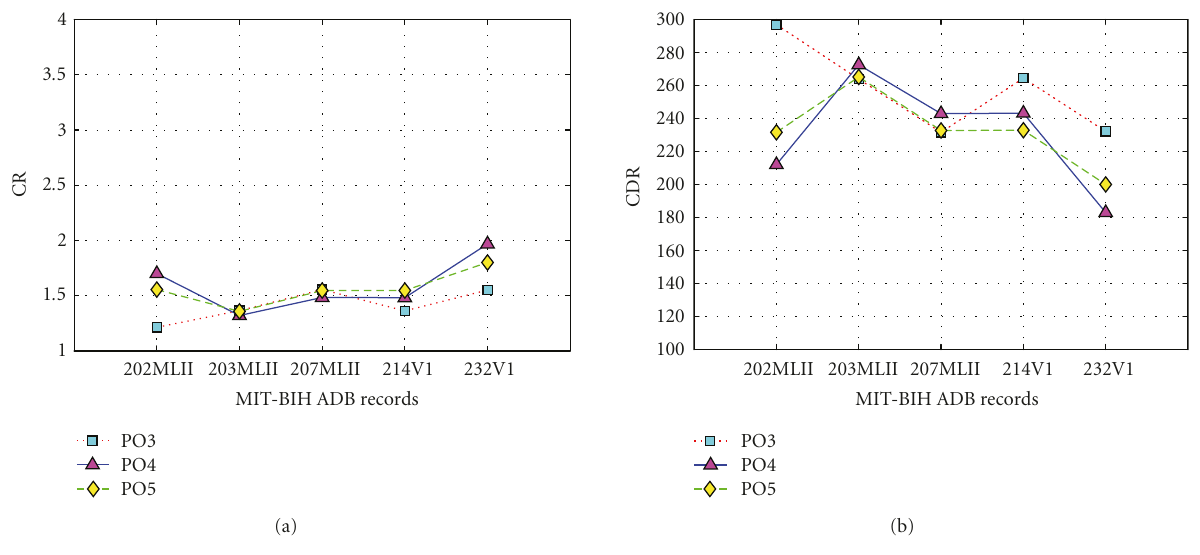
Figure 5: Compression e ffi ciency performance results on short-duration datasets with di ff erent predictor orders: (a) CR and (b) CDR for P